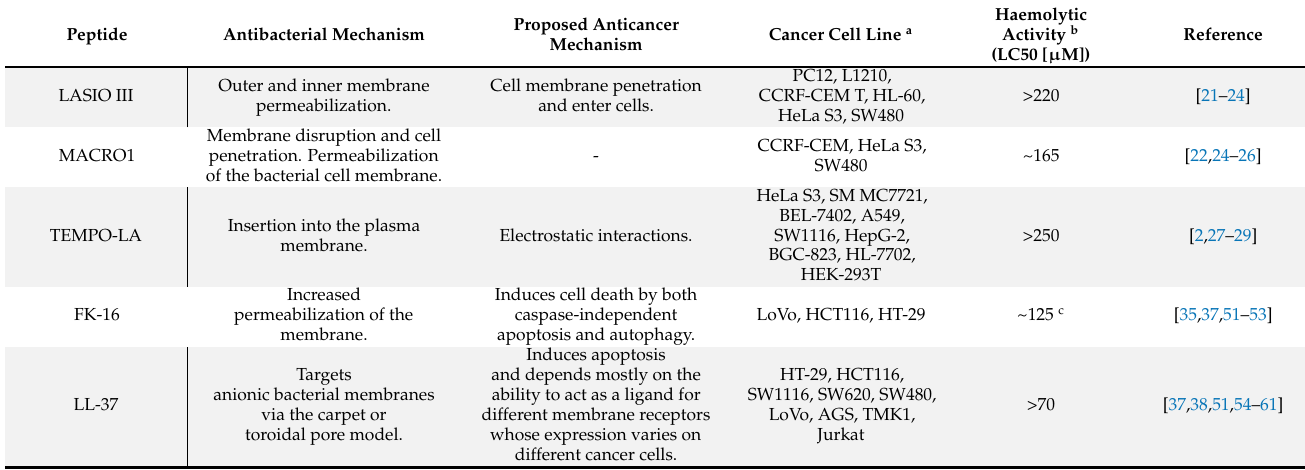
Haemolytic Activity b Reference (LC50 [ µ M]) PC12, L1210, CCRF-CEM T, HL-60,